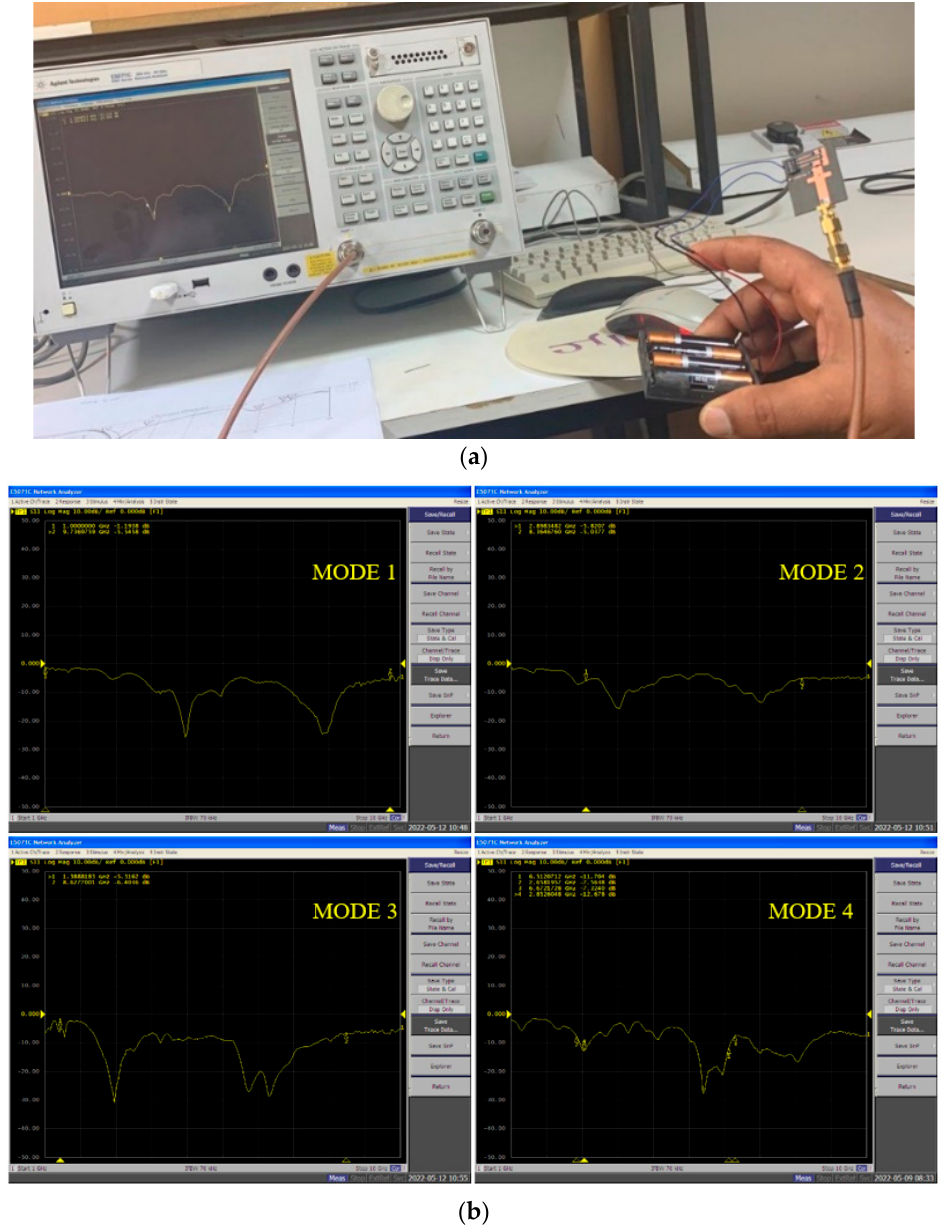
Figure 7. The reflection coefficient: ( a ) setup of antenna used to determine the reflection coefficient of (S 11 ), ( b ) S 11 measured using Agilent Technologies E5071C.